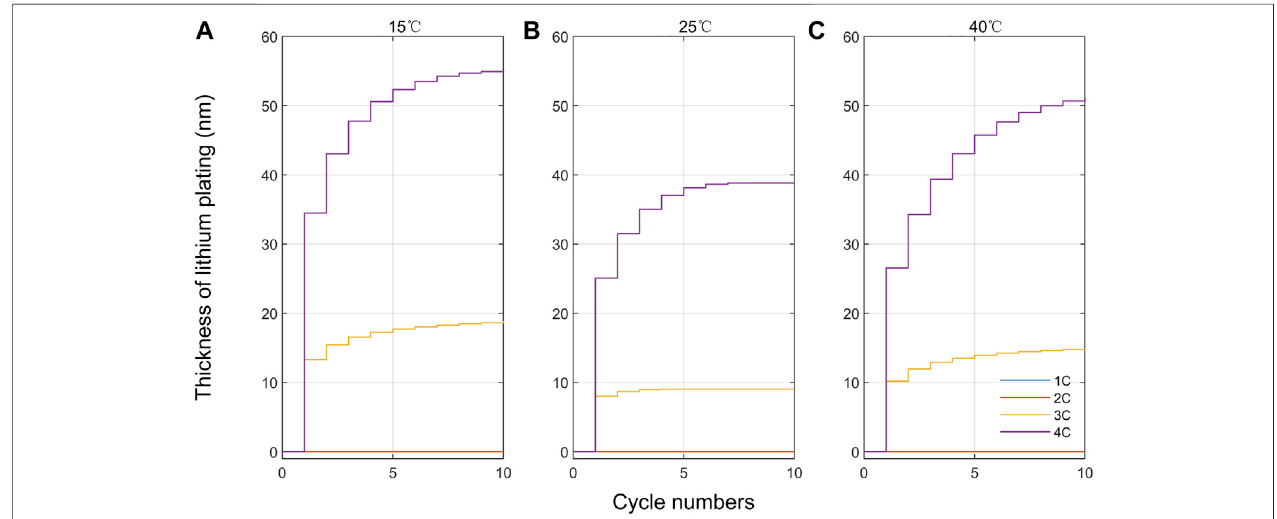
FIGURE 8 | Relationship of lithium plating thickness and cell SOC charged under high charge rate at 0 ° C.